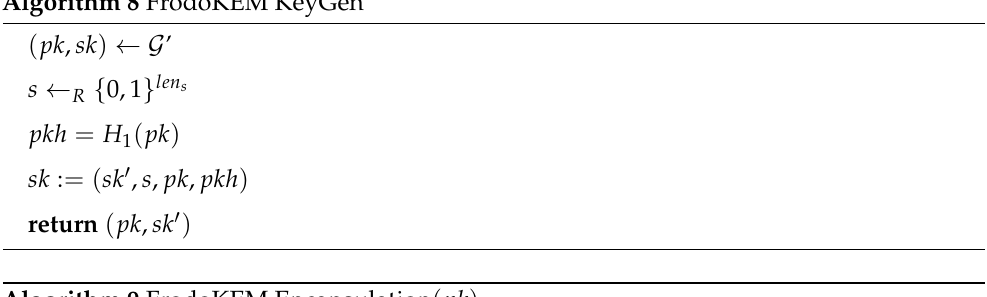
Algorithm 9 FrodoKEM Encapsulation ( pk )